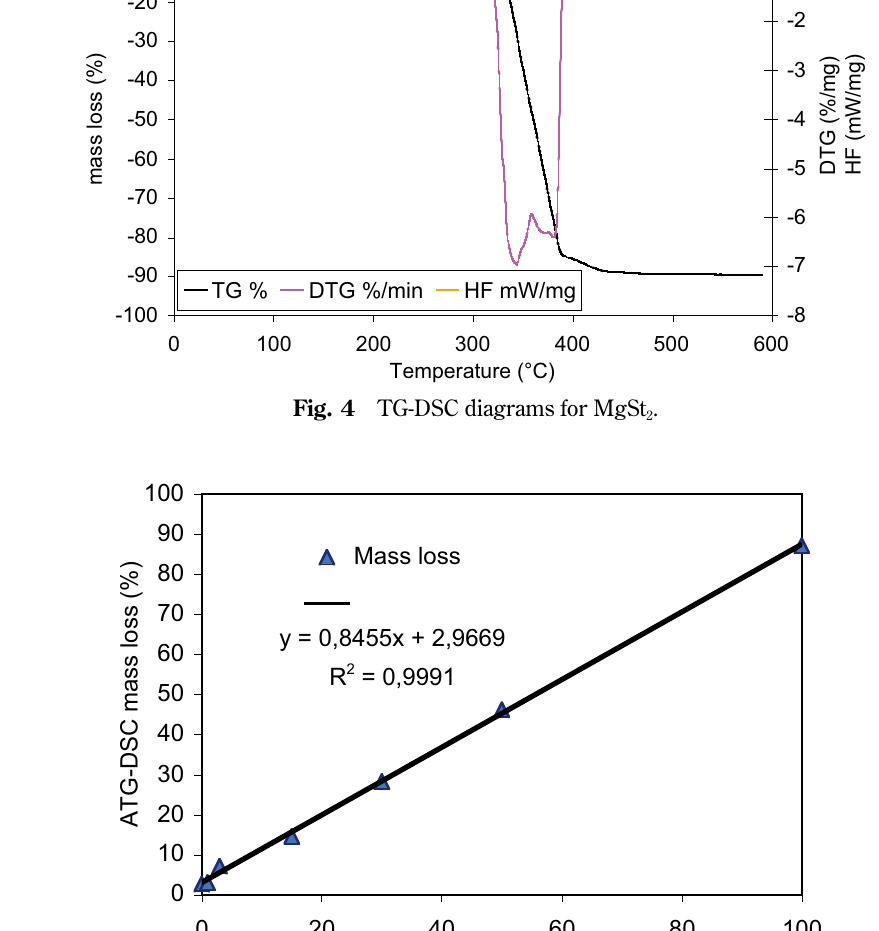
Fig. 5 Experimental relation between the TG-DSC mass loss (from 250 (cid:155) C to 600 (cid:155) C) and the mass ratio of MgSt